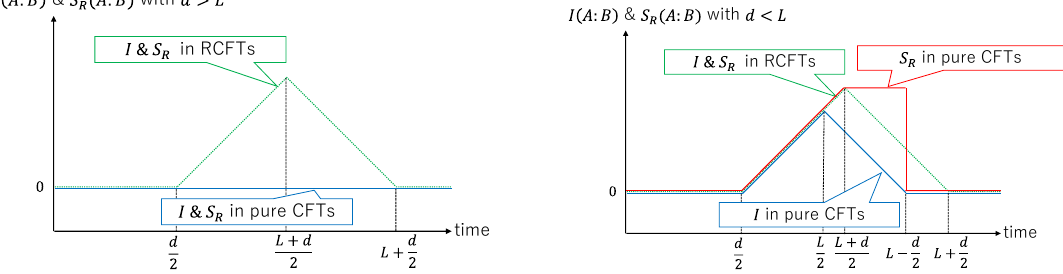
Figure 10 . Left: the time evolution of the mutual information and the re(cid:13)ected entropy under the global quench with d > L . The holographic result (blue line) is always zero, which strongly violates the quasi-particle picture (green dashed line). Right: the time evolution when d < L . In this case, the re(cid:13)ected entropy behaves di(cid:11)erently from the mutual information, which is a new signature of